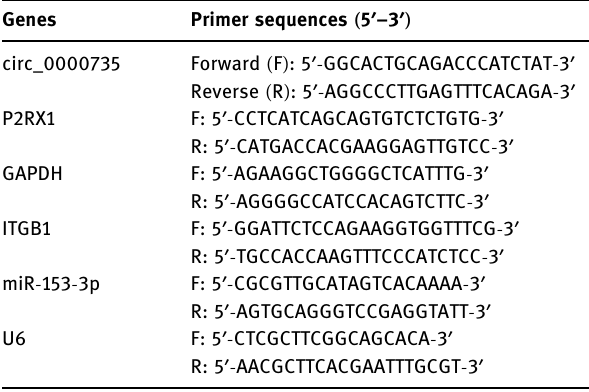
Table 1: Primer sequences used for RT -